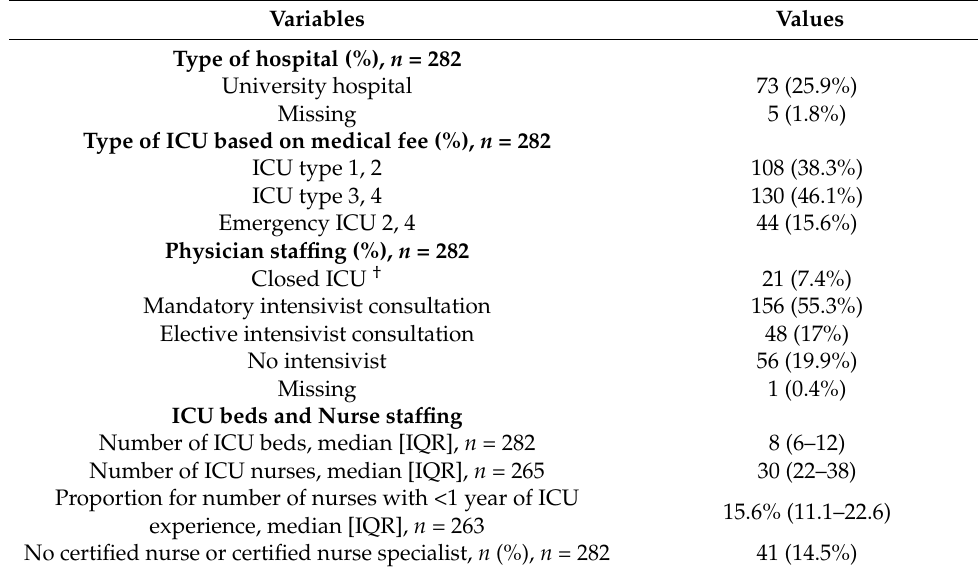
Table 1. Characteristics of the intensive care units included in the analysis.